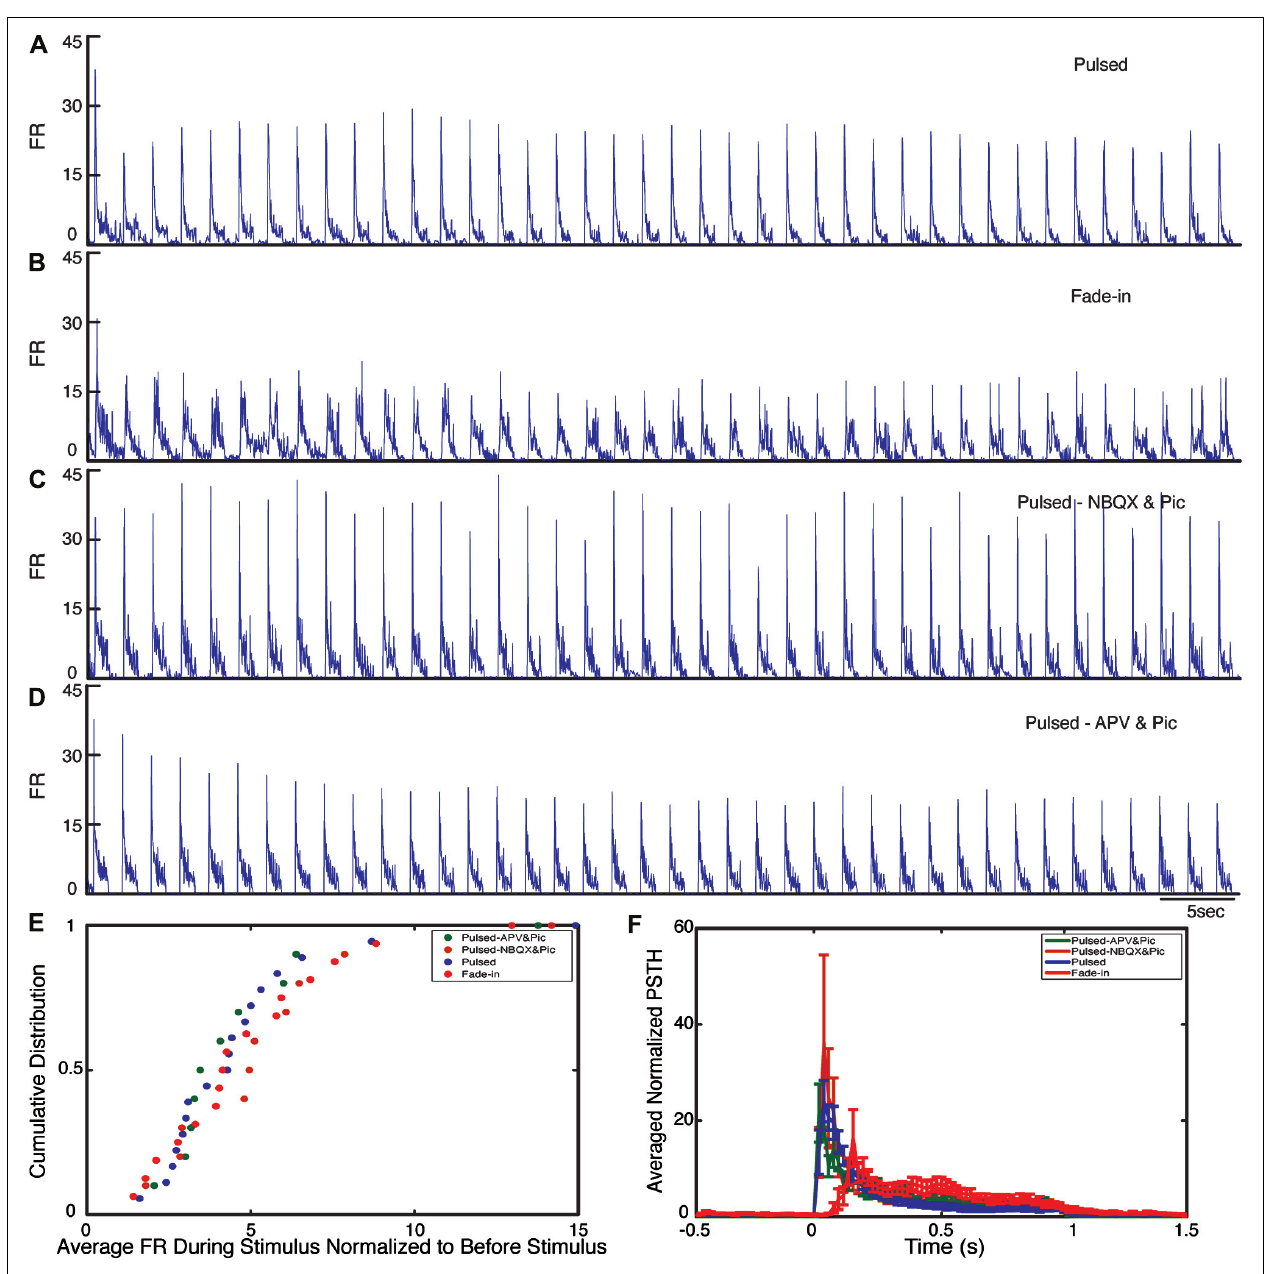
FIGURE 3 | Evoked activity during light stimulation. (A–D) Average normalized firing rate (FR) during each pulse of stimulation (normalized to the average FR before stimulus) for pulsed ( n = 18 experiments), fade-in ( n = 16 experiments), pulsed stimulation on cultures with presence of